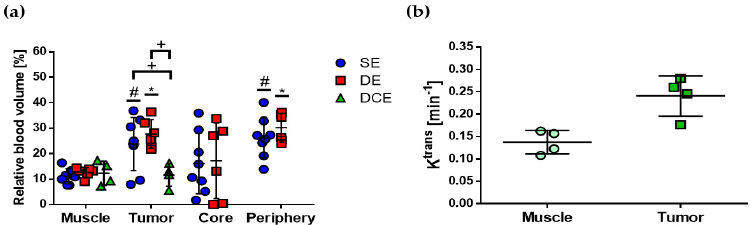
Figure 5. Quantitative imaging parameters from SE, DE, and DCE images of the subcutaneous C6 glioma model. ( a ) Mean and standard deviation are indicated in the scatter plot of rBV, which was quantified from SE ( n = 8), DE ( n = 6), and DCE ( n = 4) images. ( b ) Mean and standard deviation are indicated in the scatter plot of K trans , which was quantified from DCE images ( n = 4). Statistically significant differences ( p < 0.05) were evaluated with two-way ANOVA and t -test for rBV and K trans , respectively, and are indicated for each comparison: ( + ) SE vs. DE, SE vs. DCE, DE vs. DCE; (#) muscle vs. VOIs in SE images; (*) muscle vs. VOIs in DE